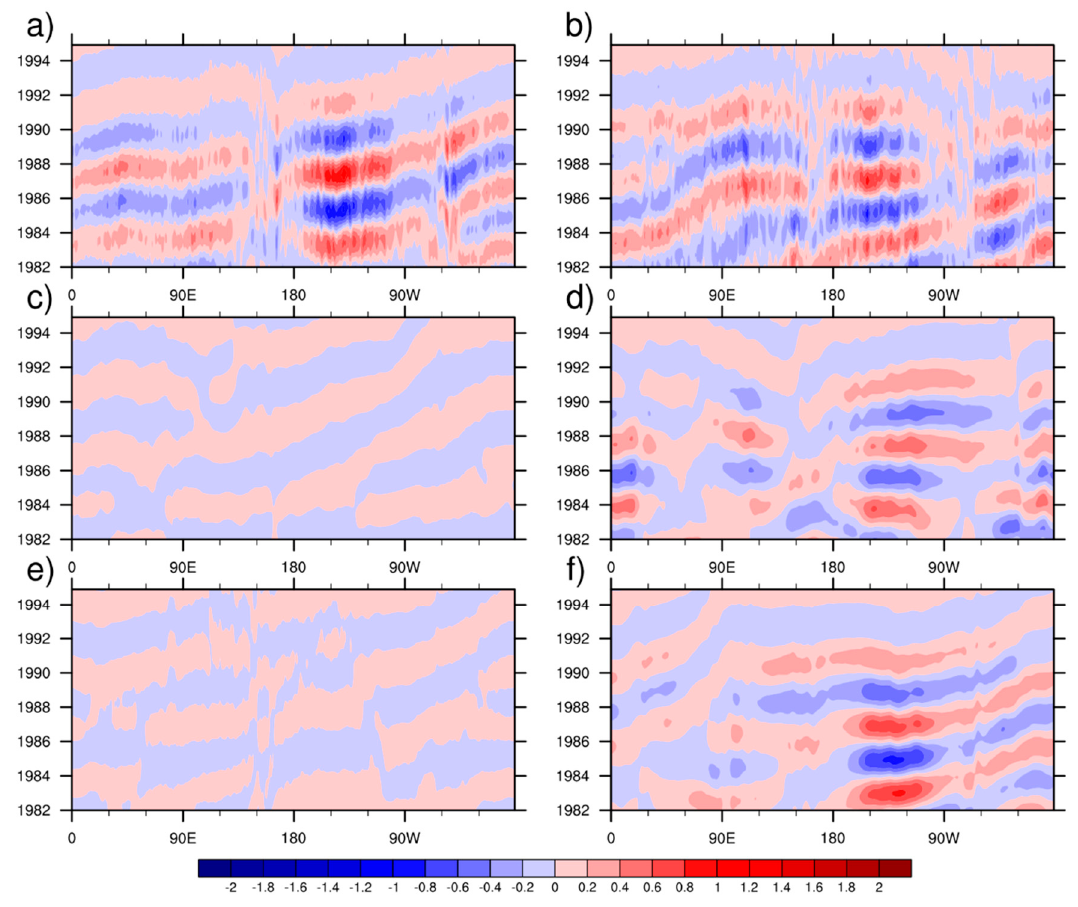
Figure 6. Same as Figure 3, but for SST (contours at 0.2 ◦ C interval). ( a ) ERA5 (as reference data); ( b ) GFDL-CM4 model (highest S score); ( c ) CMIP5 ensemble mean; ( d ) ACCESS1.3 model (highest EOF1 time series correction in CMIP5); ( e ) CMIP6 ensemble mean and ( f ) CESM2 model (second highest EOF1 time series correction in CMIP6 with GFDL-CM4 as the highest).